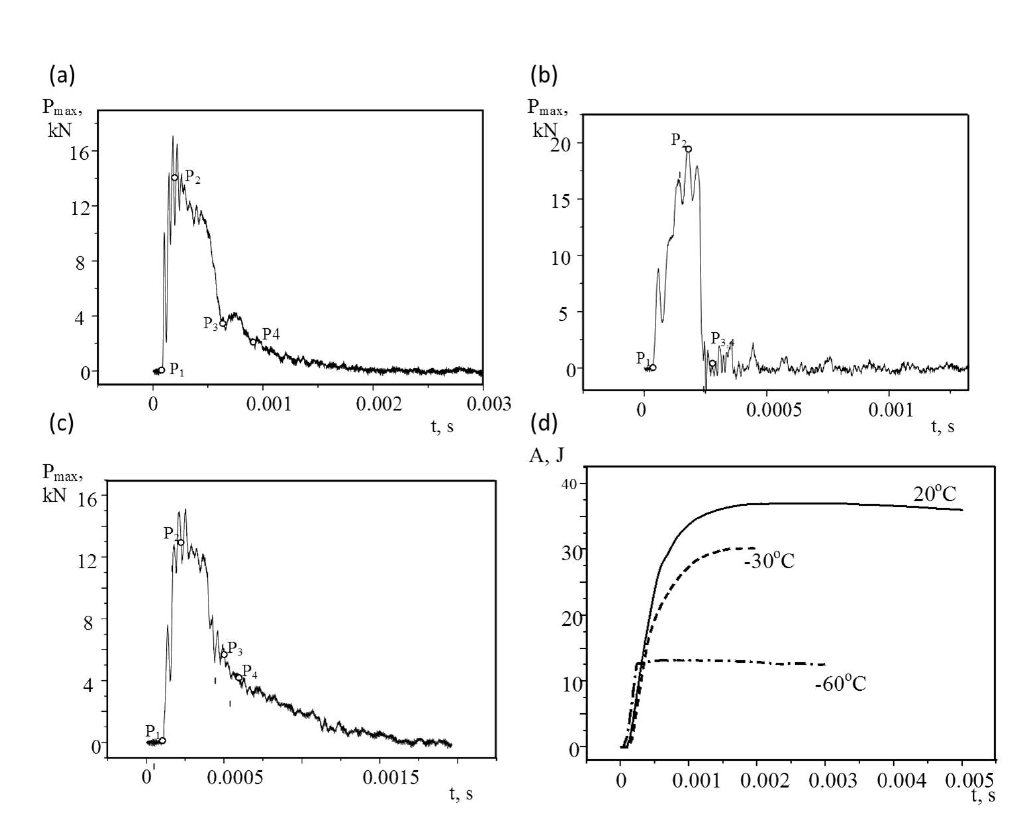
Figure 4. Dynamic influence on Charpy specimens (type I, see Figure 1) at 20 ◦ C (a), -30 ◦ C (b), -60 ◦ C (c) and variation of energy to failure with time